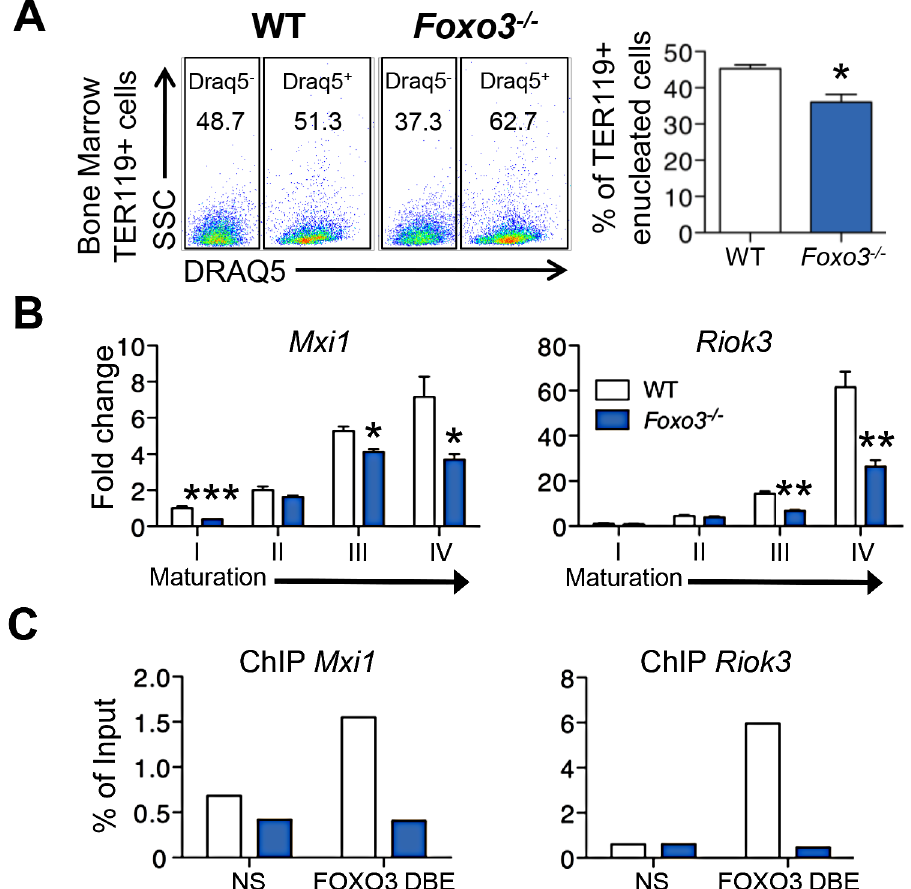
Fig 4. Impaired enucleation-related gene transcription in Foxo3 -/- bone marrow erythroblasts. (A) WT and Foxo3 -/- bone marrow TER119 + erythroblasts were analyzed for DRAQ5 staining by flow cytometry. The percentage of enucleated TER119 + cells is shown (lower panel). Results are mean ± SEM of n = 3; one representative of four different experiments is shown. (B) QRT-PCR expression analysis by Fluidigm microfluidics technology of enucleation-related genes in WT and Foxo3 -/- Gates I to IV bone marrow erythroblasts. Quantification of target genes is normalized to β actin. Results are mean ± SEM of 3 cDNAs. (C) FOXO3 occupation of Mxi1 (left) and Riok3 (right) regulatory regions as determined by ChIP. Enrichment of putative FOXO3 DNA binding regions in Mxi1 and Riok3 promoters was analyzed by qPCR and compared to regions with no known FOXO3 binding sites. Values were normalized to Ct values from total input. One representative of two different experiments is shown. NS Not specific; DBE DNA binding element. * P < 0.05 ** P < 0.01 *** P < 0.001, Student ’ s t